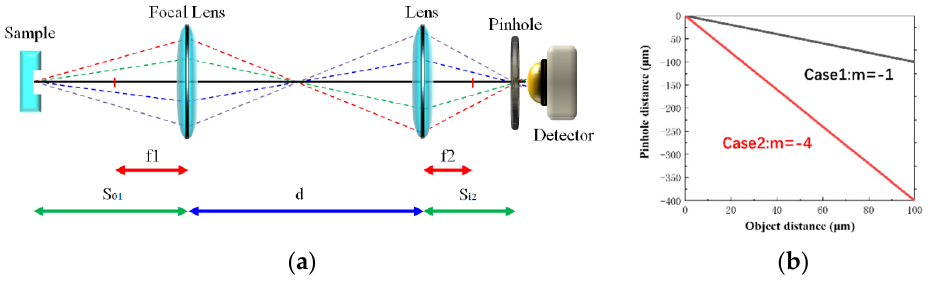
Figure 2. ( a ) Illustration of simplified confocal depth detection system; and ( b ) simulation results of the lateral sensitivity gain of 1:1 (blue line) and 1:4 (red line) over 100 µm of travel, respectively. (Case 1: f 1 = 50 mm, f 2 = 50 mm; Case 2: f 1 = 50 mm, f 2 = 100 mm).